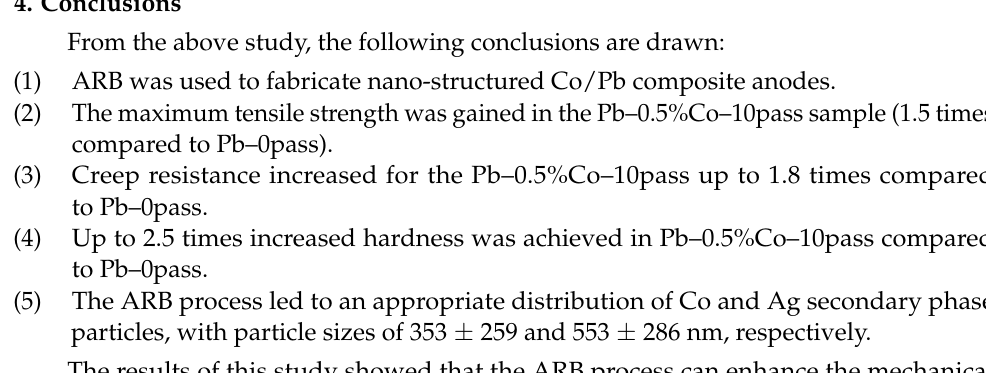
of ARB. Figure S2: Shear punch test of different samples. Figure S3: Tensile strengths and shear strengths of different